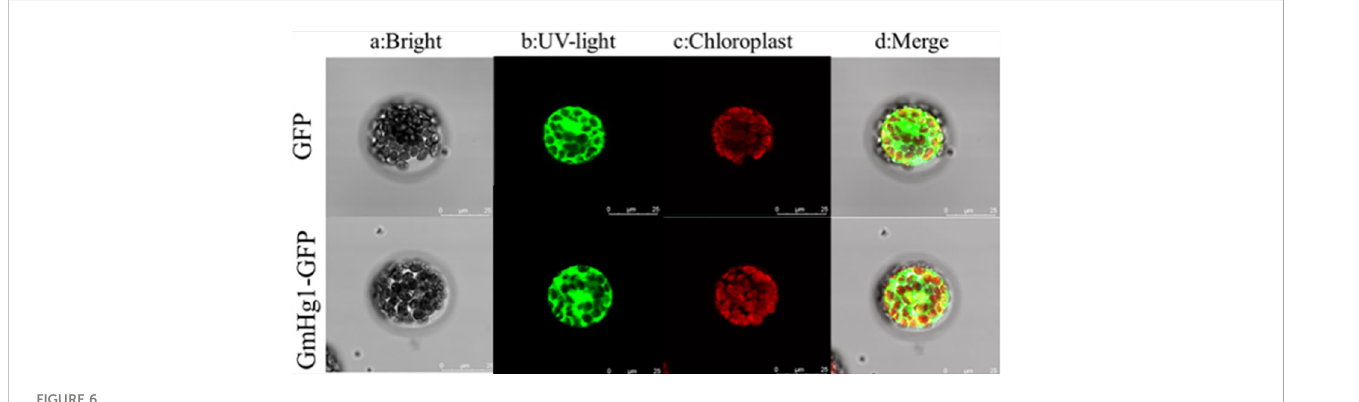
FIGURE 6 Subcellular localization of GmHg1 .